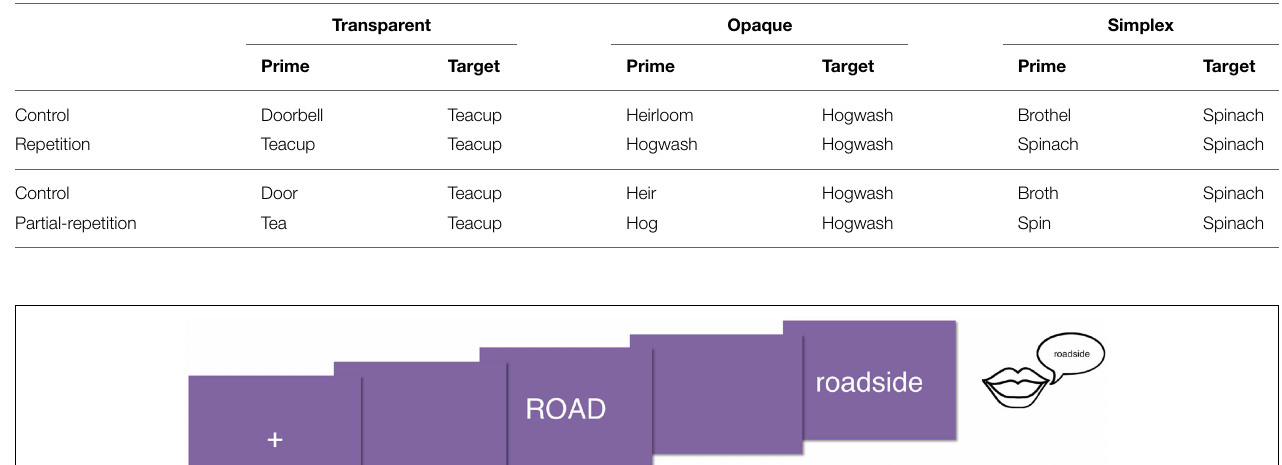
TABLE 1 | Design matrix.